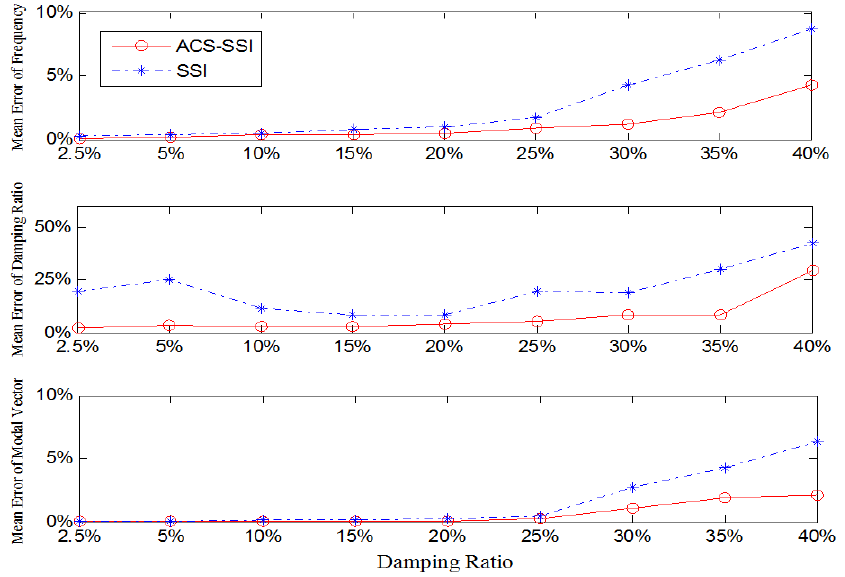
Figure 3. Identification error varying the damping ratio.